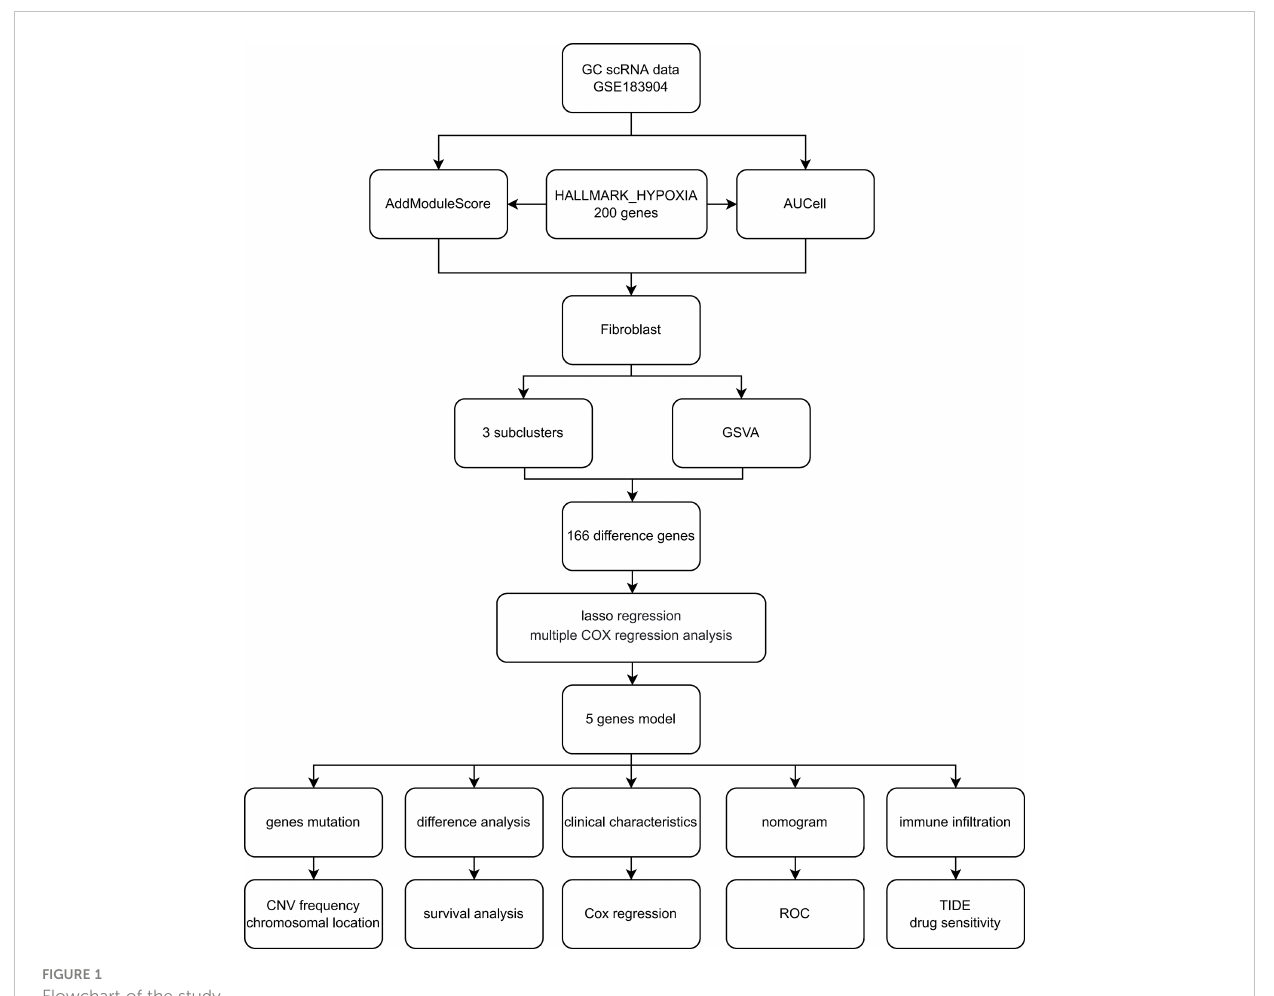
FIGURE 1 Flowchart of the